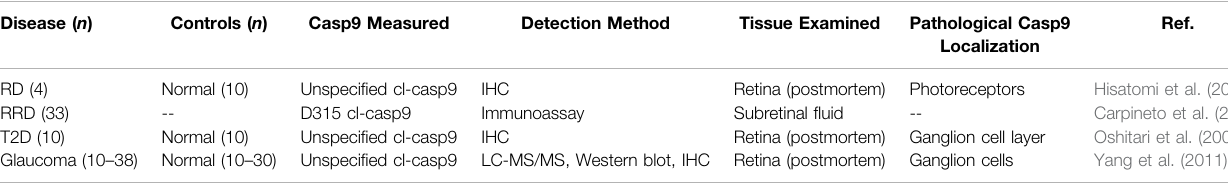
TABLE 3 | Studies reporting increased level of caspase-9 in retinal